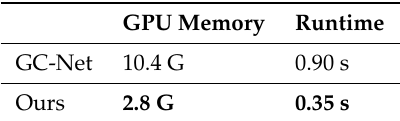
Table 2. Computational overhead of GC-Net and SCV-Net in processing a 1216 × 352 image pair on a single NVIDIA GTX